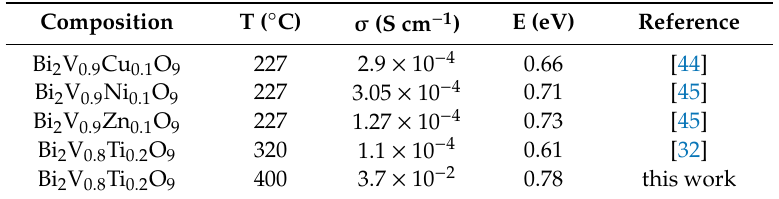
Figure 6. Arrhenius plots of BITIVOX sintered at 800 ◦ C / 8 h and flash sintered at 700 ◦ C / 5 min and 800 ◦ C / 5 min. Table 1. Reported and this work values of electrical conductivity σ and activation energy E.